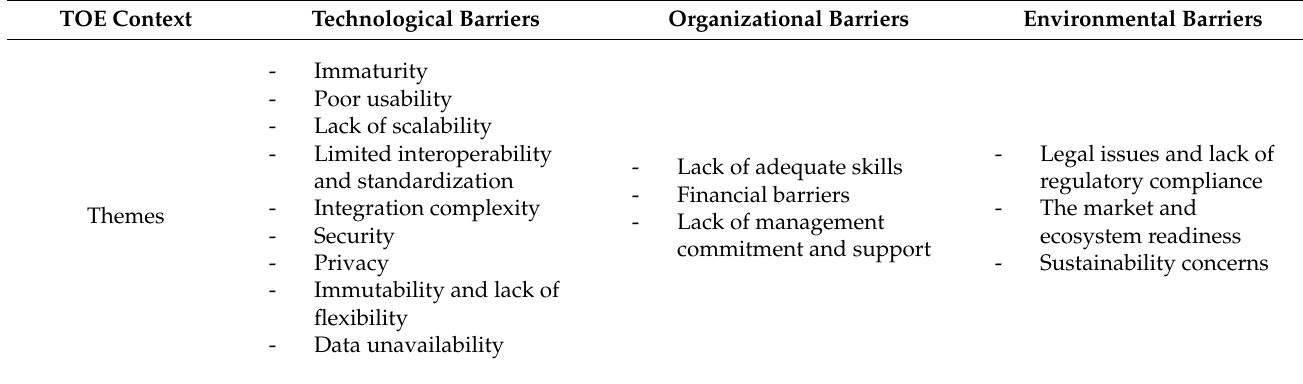
Table 2. Identified barriers for blockchain adoption in HEIs (n =